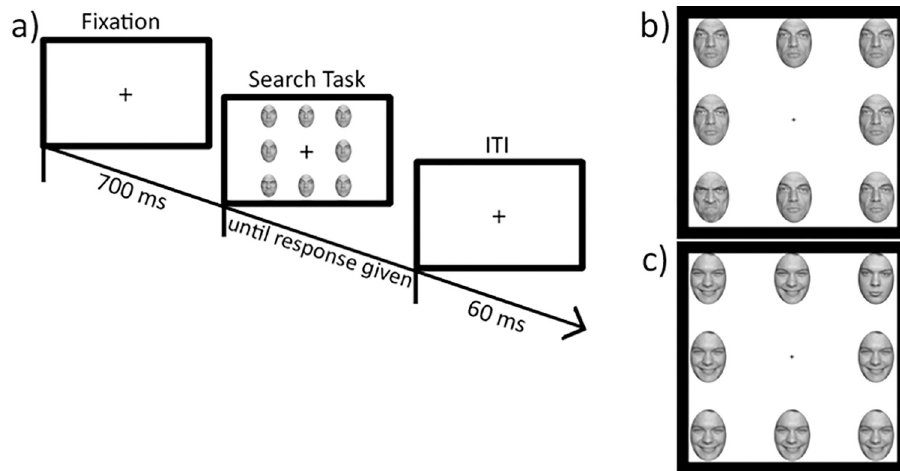
Fig 2. Experimental set-up of the VST. Experimental trial (a) and example “search task” arrays of the facilitation (b) and interference (c) conditions of the VST. Participants are presented with an array of eight faces and required to detect whether there is a divergent target present or whether all faces are the same. Both example arrays represent target-present trials.